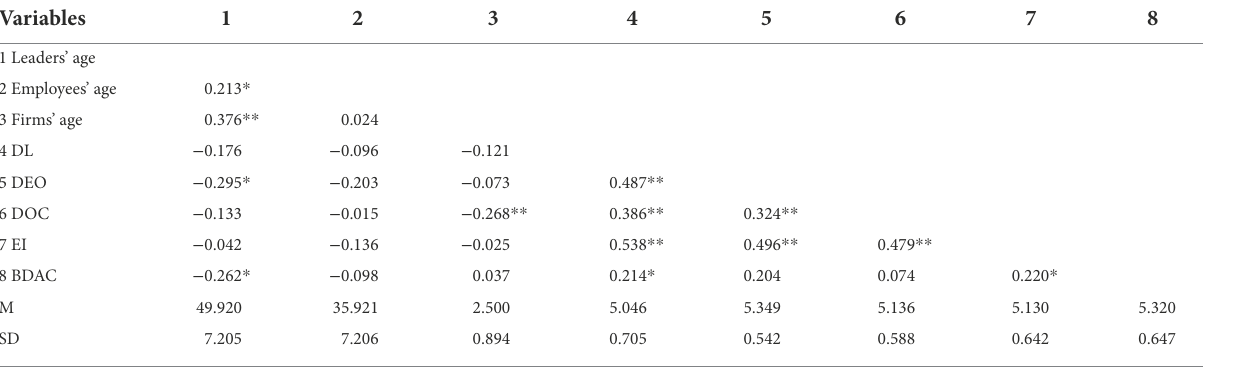
TABLE 1 Means, SD, and correlations of all variables. Variables